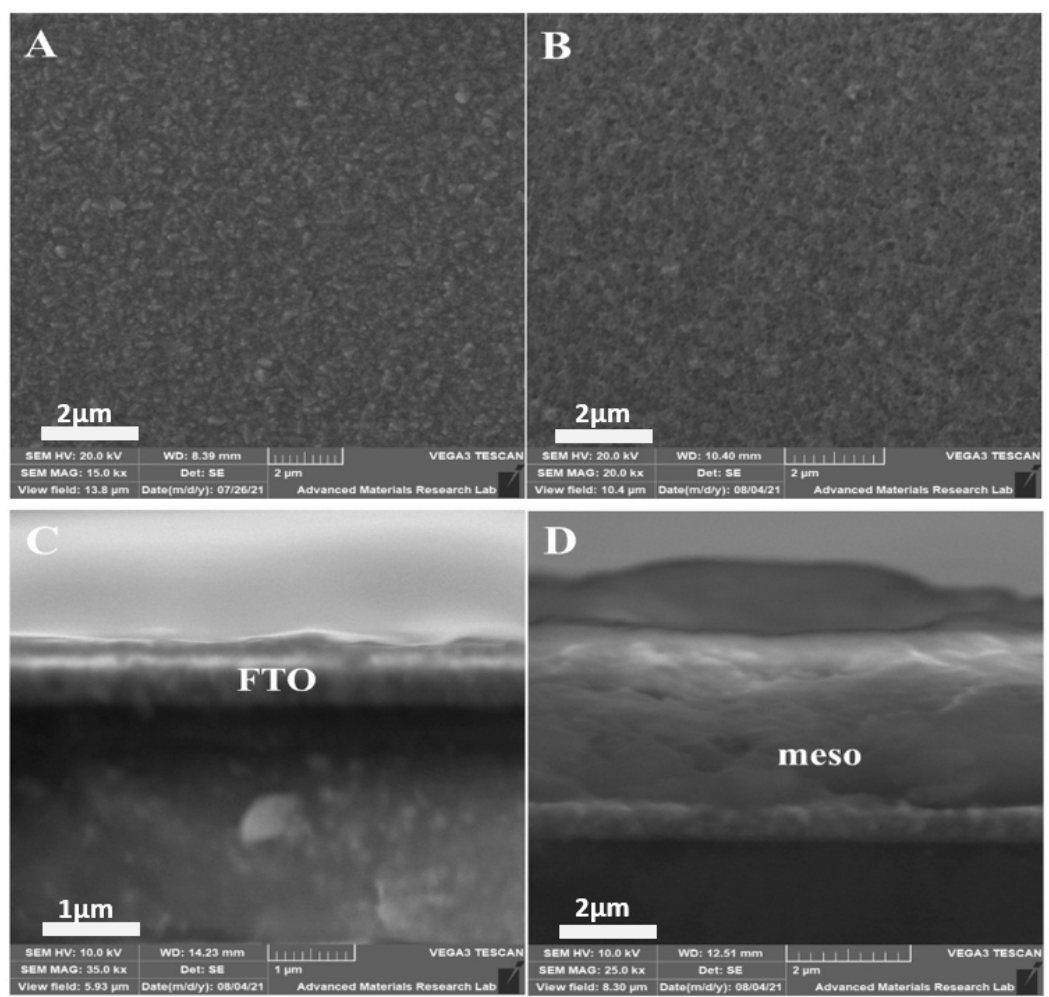
Figure 8. Front view SEM micrographs of Sample D ( A ); Front view SEM micrographs of Sample L ( B ); Cross-sectional side view SEM micrographs of Glass/FTO ( C ); Cross sectional top view SEM micrographs of Sample L ( D ).